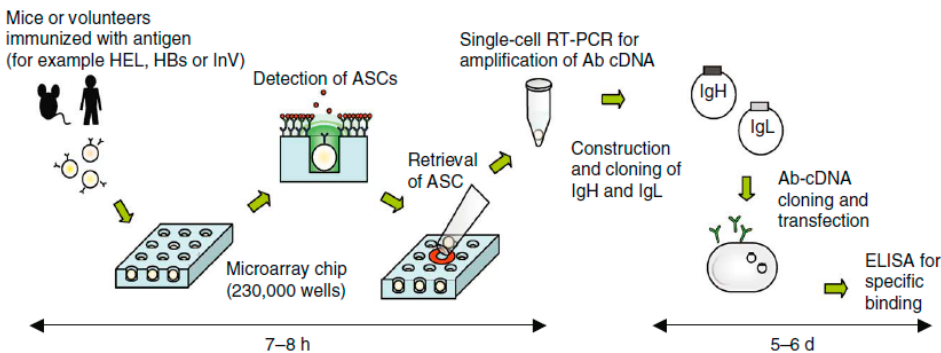
Figure 19. Schematic representation of the micro array-based detection and retrieval of targeted antibody secreting cells and downstream analysis. Reprinted with permission from [154]. Copyright (2009) Springer Nature.